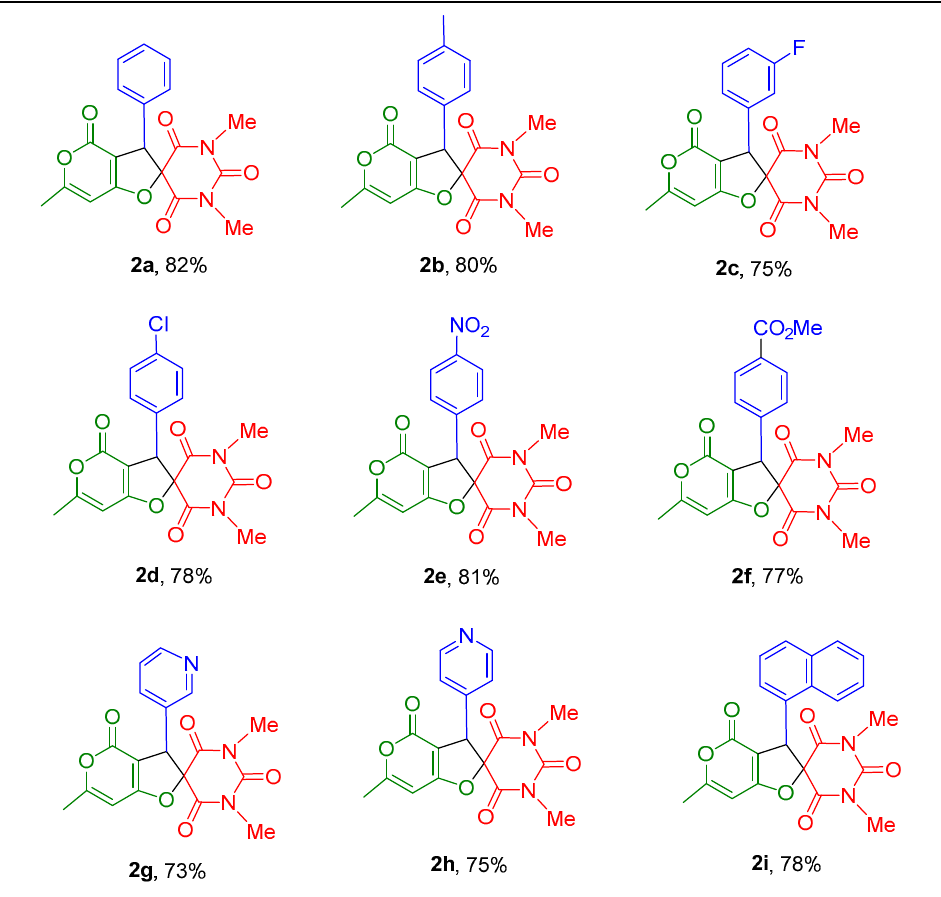
Table 2. Electrocatalytic multicomponent synthesis of spiro[furo[3,2- b ]pyran-2,5 ′ -pyrimidine] 2a – i